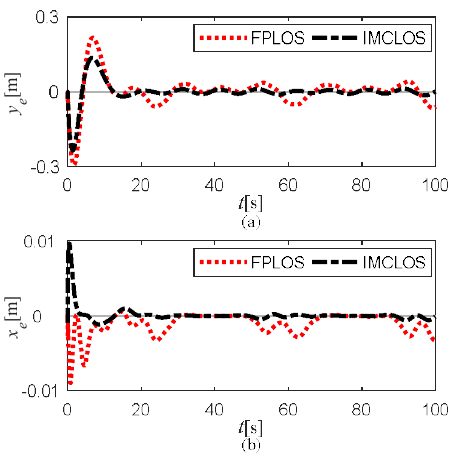
Figure 7. x e ( b ) and y e ( a ) from IMCLOS and FPLOS.